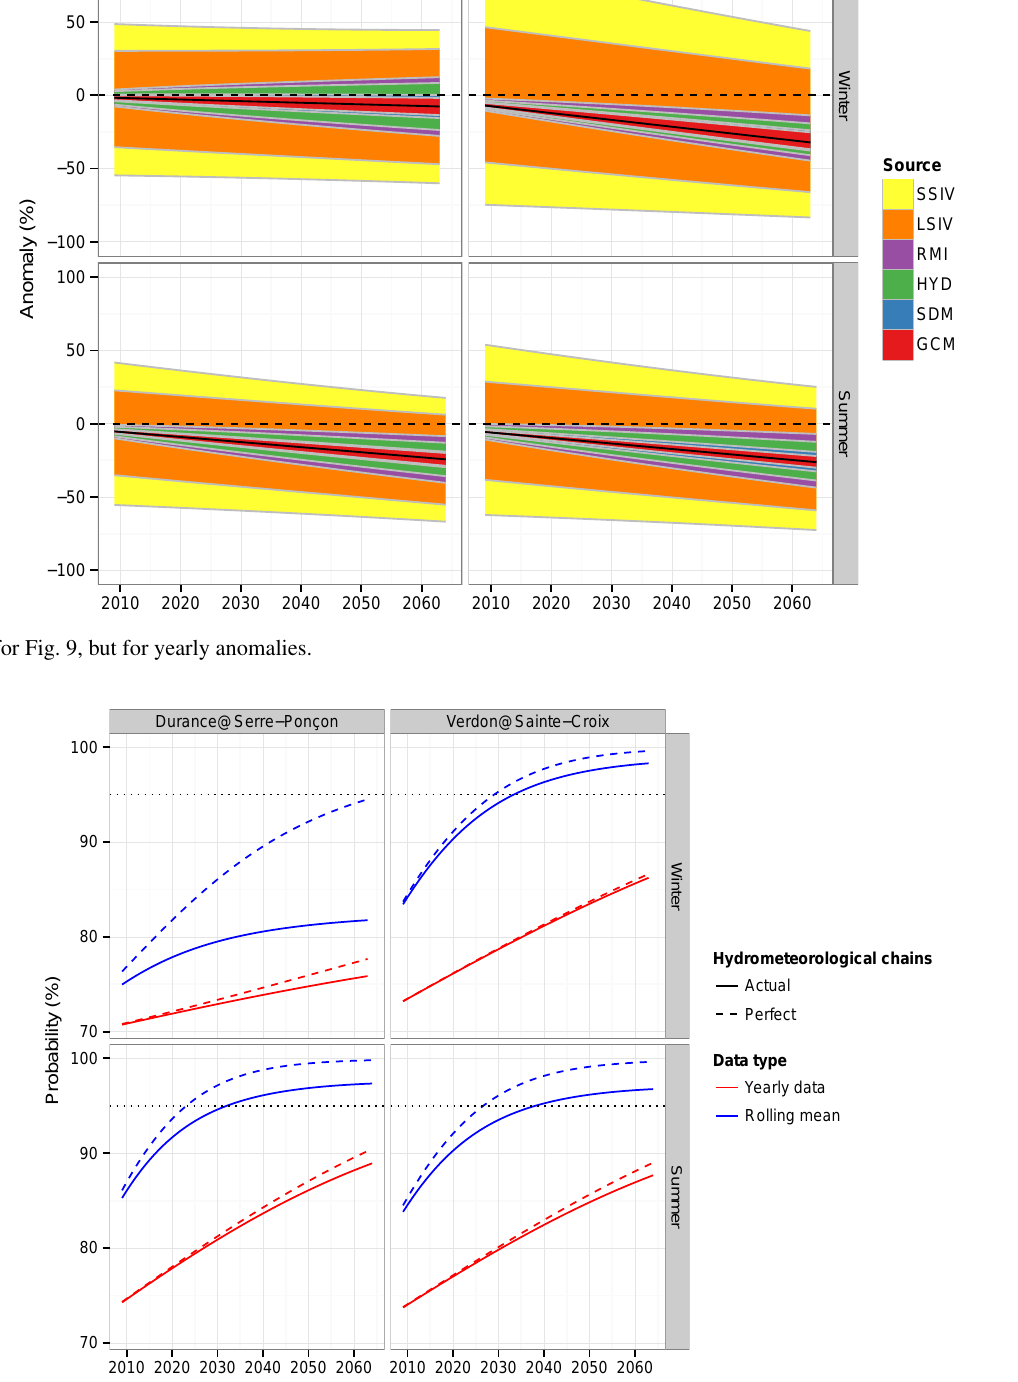
Figure 11. Evolution of the probability of a low flow below the REF period average, for yearly anomalies and 30-year rolling averages, with the hydrometeorological model chains used here and with a perfect hydrometeorological model (see text for